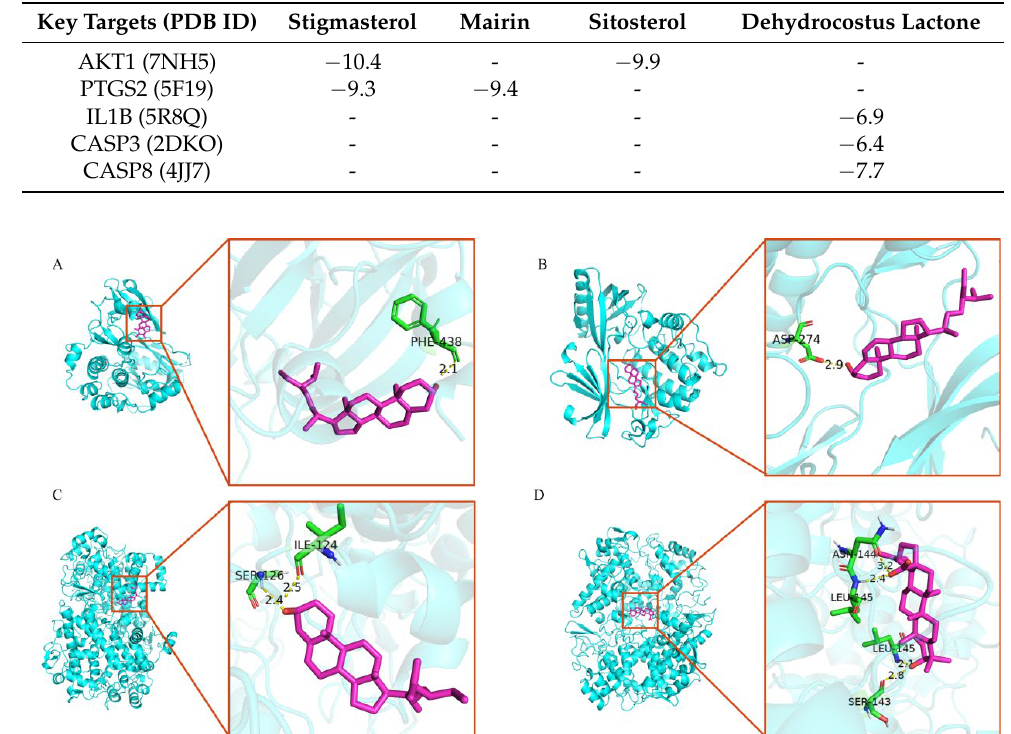
Figure 7. The 3D interaction diagrams of AR core targets against GU. ( A ) The docking result of AKT1 with stigmasterol. ( B ) The docking result of AKT1 with sitosterol. ( C ) The docking result of PTGS2 with stigmasterol. ( D ) The docking result of PTGS2 with mairin. The purple sticks indicate the ligands, the green sticks indicate the active site residues of targets, and the hydrogen bonds are indicated by yellow dotted lines.